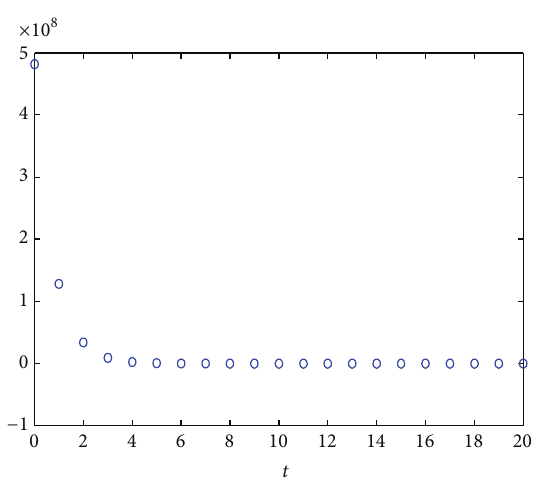
Figure 2: The minimum eigenvalue of 𝑃